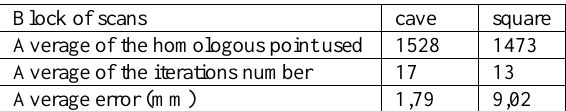
Table 2. Scans alignment deviations